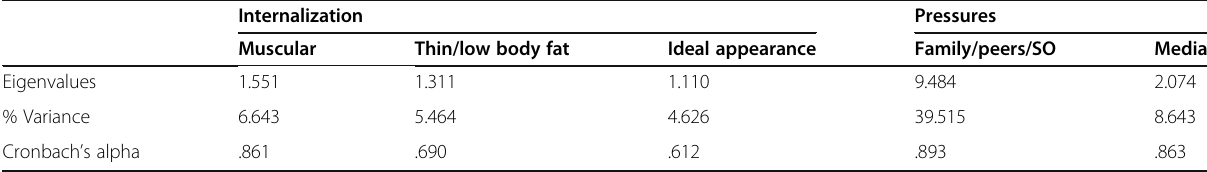
Table 6 EFA indicators from the solution of five factors for SATAQ-4R-Male Internalization Pressures Muscular